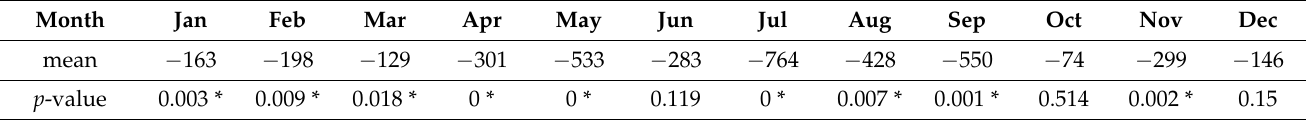
Table 5. Paired sample t -test for months of 2017 and